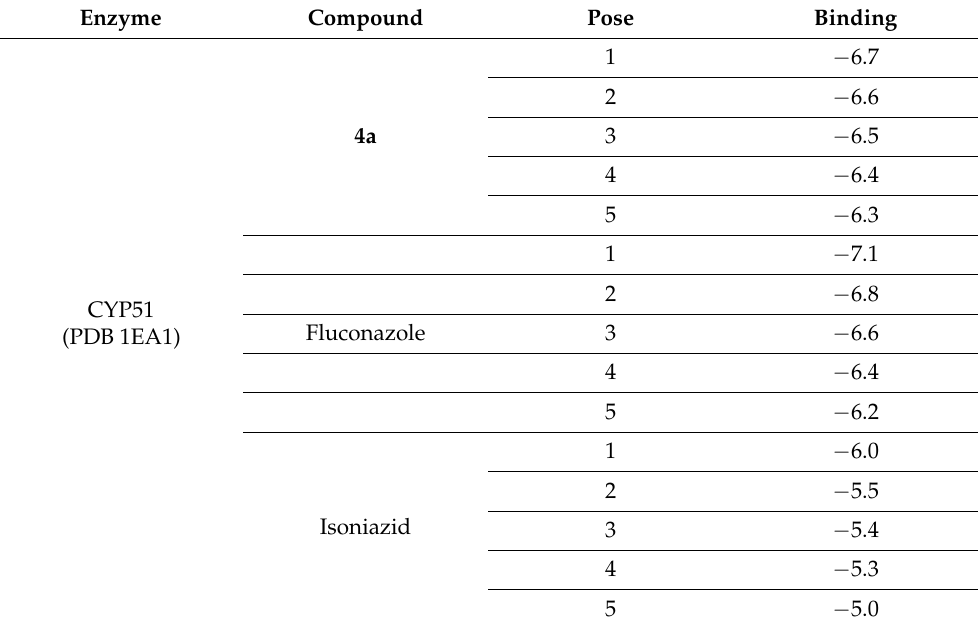
Table 2. Binding energy between cytochrome P450 14 alpha-sterol demethylase (CYP51) with compound 4a and controls (fluconazole and isoniazid) for all